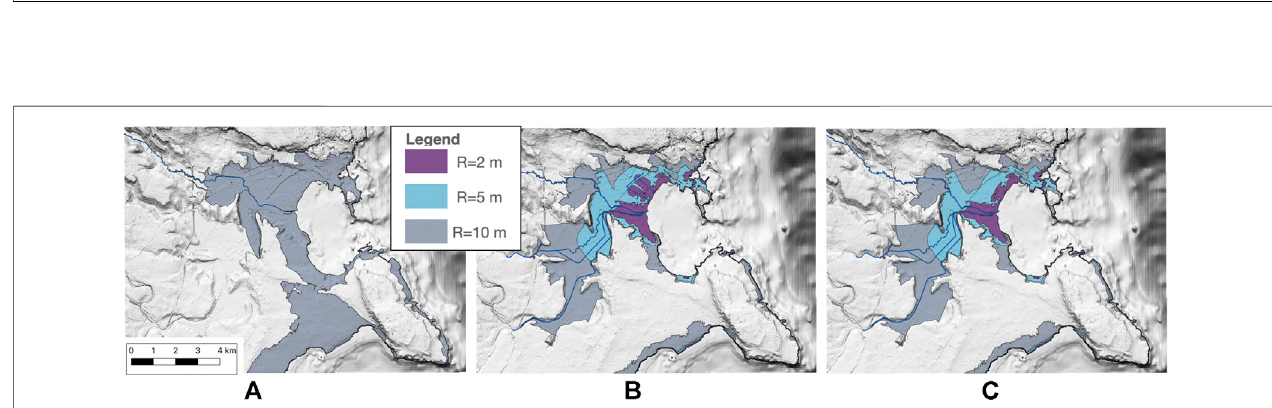
FIGURE 5 | The fi rst generation inundation map of Catania [panel (A) ] is compared with the GIS-based version inundation maps calculated for this work, using the more detailed DTM described in Inundation Maps for the Case-Studies inSouth-Eastern Sicily section, for different values of R p d and considering [panel (B) ] or not [panel (C) ] additional secondary river beds.